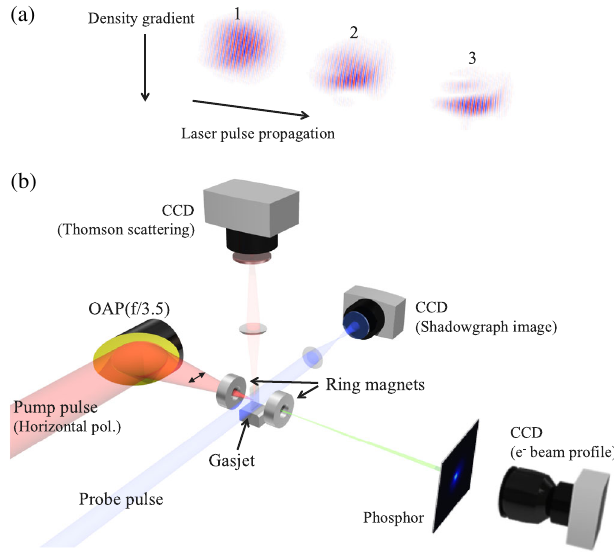
FIG. 1. (a) Dynamics of a laser pulse field in a semiparabolic plasma channel near a scattering point. (b) Experimental